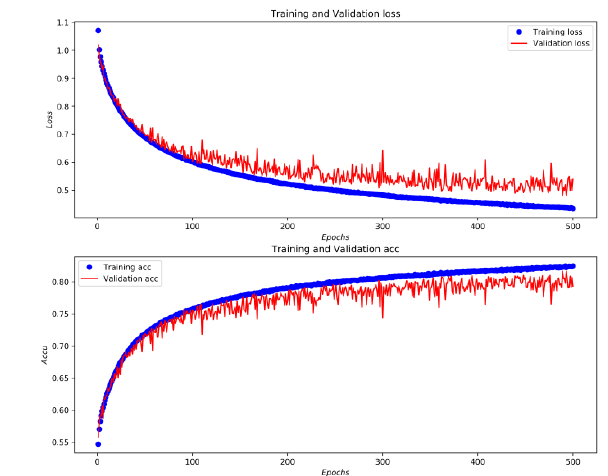
Figure 4. Convergence curve.